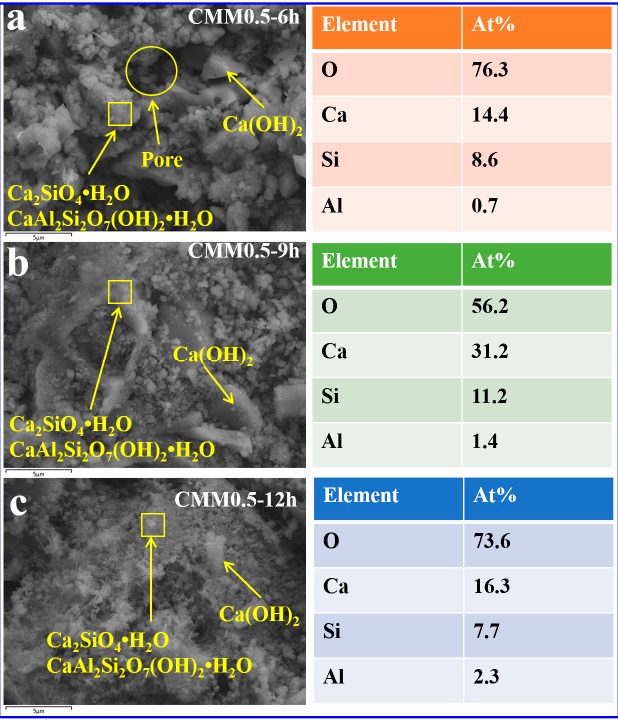
Figure 14. SEM ‐ EDX results of CMM0.5 at autoclaved ( a ) 6, ( b ) 9 and ( c ) 12 h. Figure 14. SEM-EDX results of CMM0.5 at autoclaved ( a ) 6, ( b ) 9 and ( c ) 12